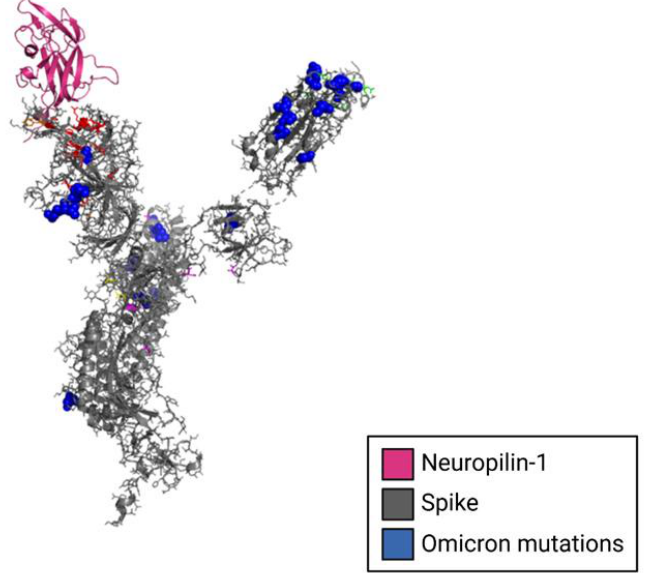
Figure 6. Structural model of Neuropilin-1 complexed to the NTD of the SARS-CoV-2 spike glycoprotein monomer. The cryo-EM structure of the spike protein monomer is shown in gray complex to neuropilin-1, shown in magenta. Spike mutations from the omicron variant are shown in blue.